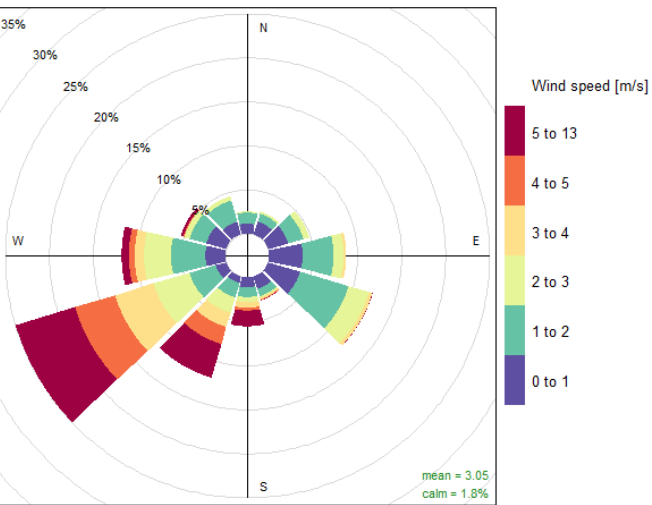
Figure 4. Wind conditions during the period under consideration. Figure generated using openair package [38].